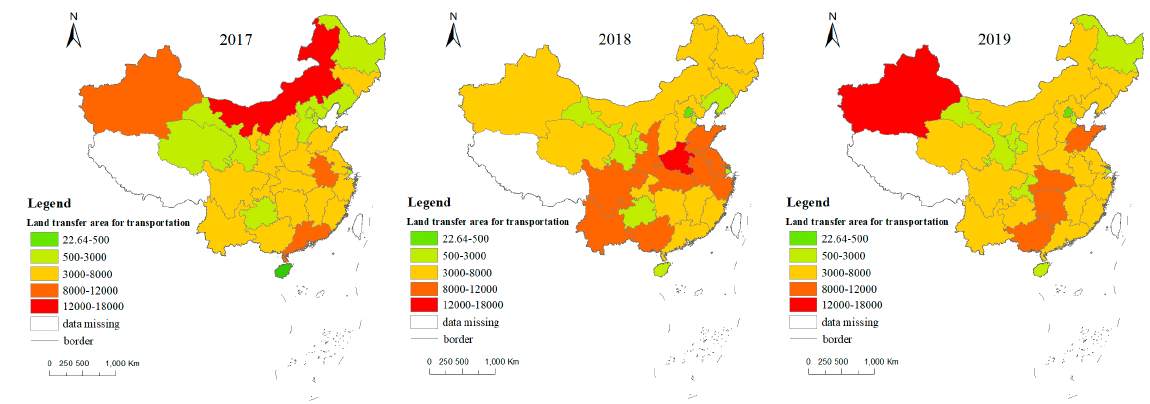
Figure 2. Spatial and temporal distribution and evolution trend of the TLT area.